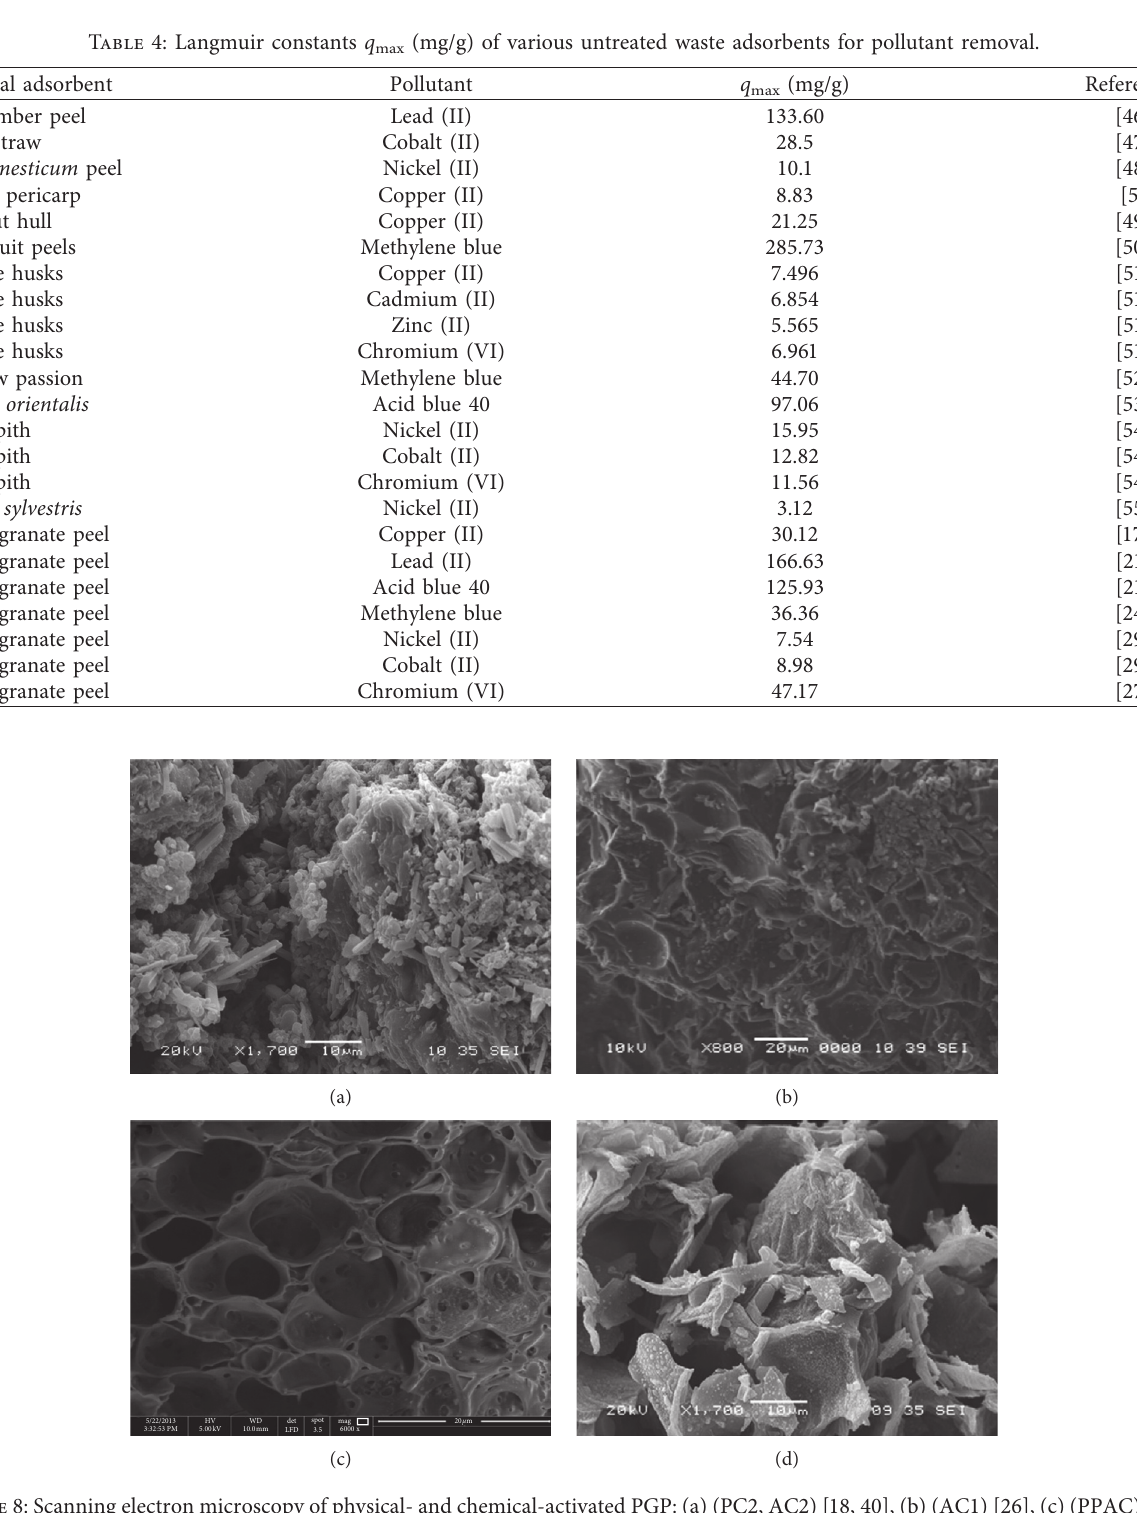
Figure 8: Scanning electron microscopy of physical- and chemical-activated PGP: (a) (PC2, AC2) [18, 40], (b) (AC1) [26], (c) (PPAC) [16], (d) (PC3, AC3) [18,